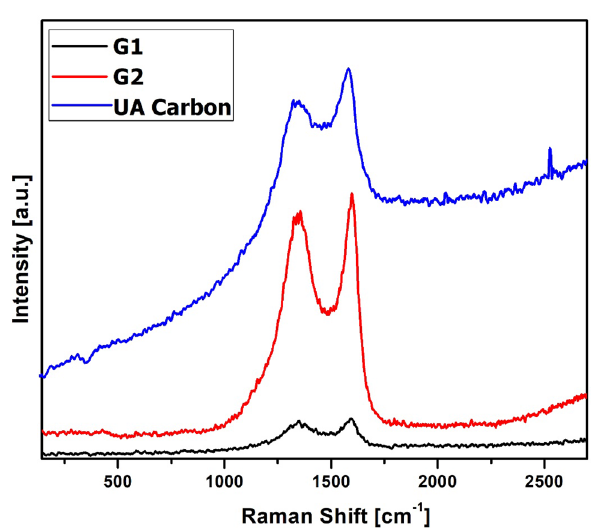
Fig. 4 Raman spectrum of ( a ) UA carbon, ( b ) G1, ( c )